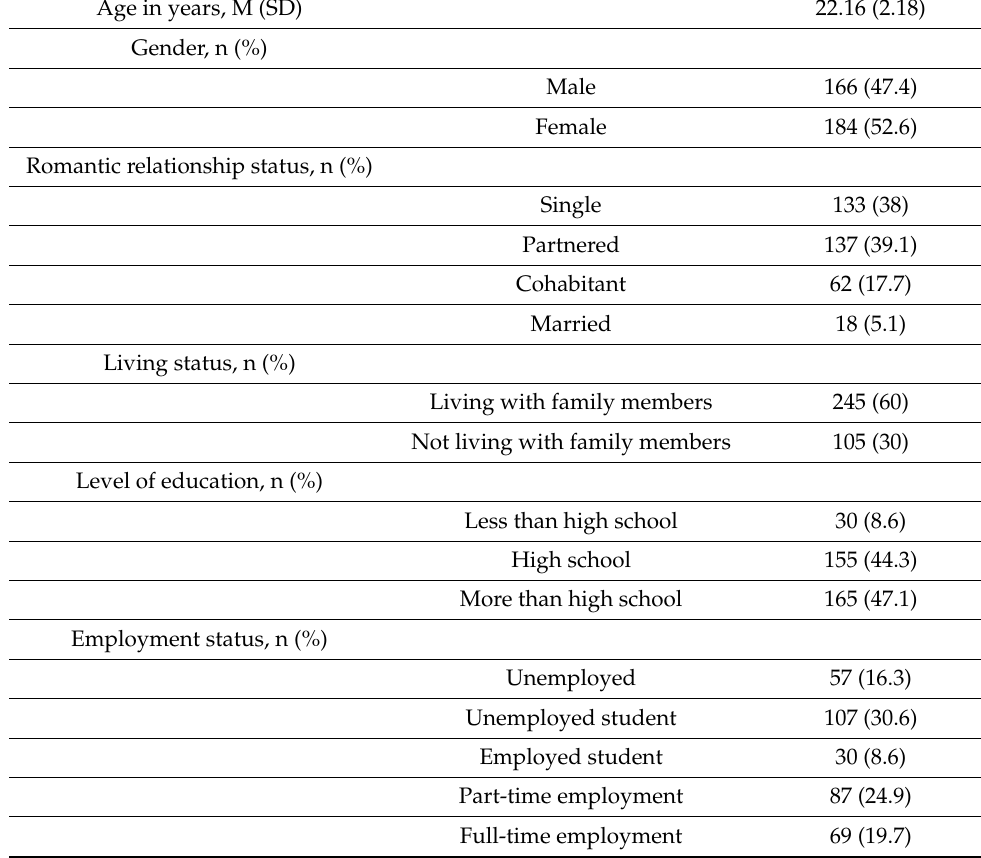
Table 1. Sample demographic